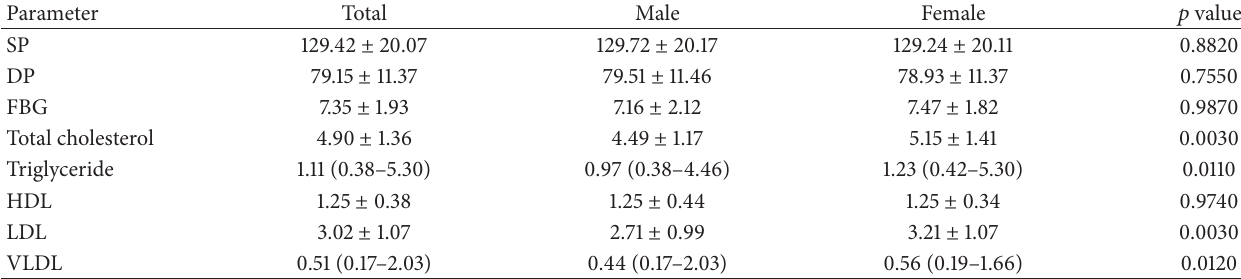
Table 3: Haemodynamic and biochemical parameters of study population stratified by gender.